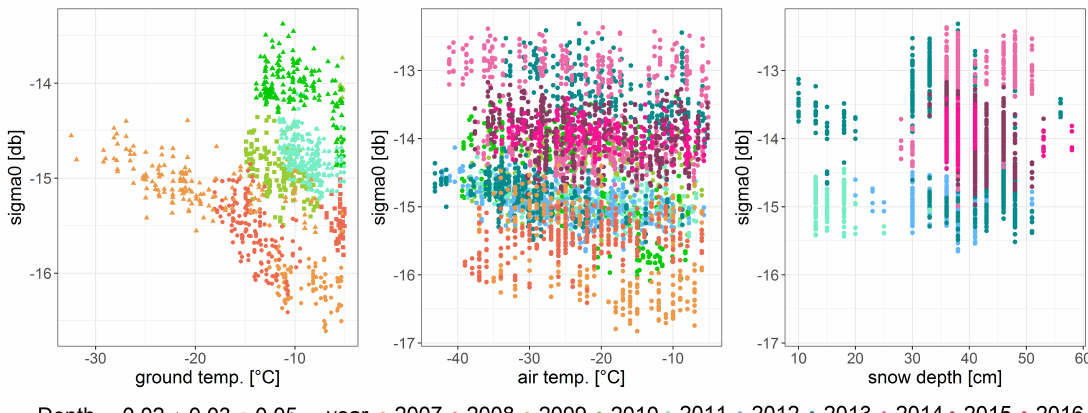
Figure 7. Scatterplots of ASCAT backscatter (dB) with ground temperature (°C) for measurements in selected depths (0.02 m, 0.03 m, 0.05 m), and air temperature (°C) and snow depth (cm) for selected years for for Grid Point 3056638, SNOTEL Station 1183 Sagwon, AK and Borehole Sagwon MNT